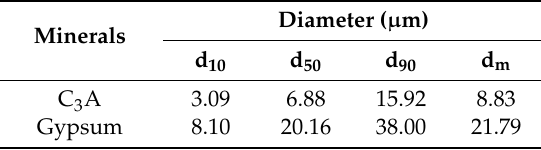
Table 1. Particle size distribution of minerals.